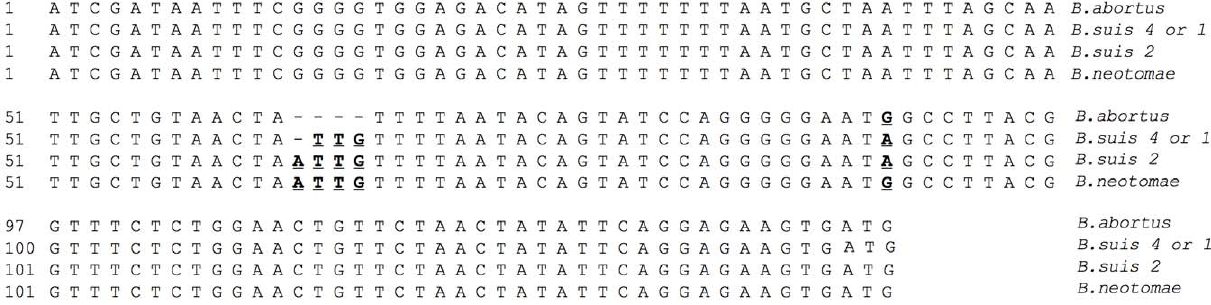
Figure 3. Multiple alignment of nucleotide sequences of the 5 9 flanking region of sodC start codon from B.abortus , B.suis biovars 4 (strain 40) or 1 (strain 1330) and 2 (strain Thomsen), and B.neotomae . Alignment was performed with the Clustal method of the MegAlign program of LaserGene software. Gaps are indicated by dashes. The nucleotides differing between B. suis and B. abortus or B. neotomae are in bold and underlined. Note: B. melitensis nucleotide sequences are identical to those of B. abortus shown above.